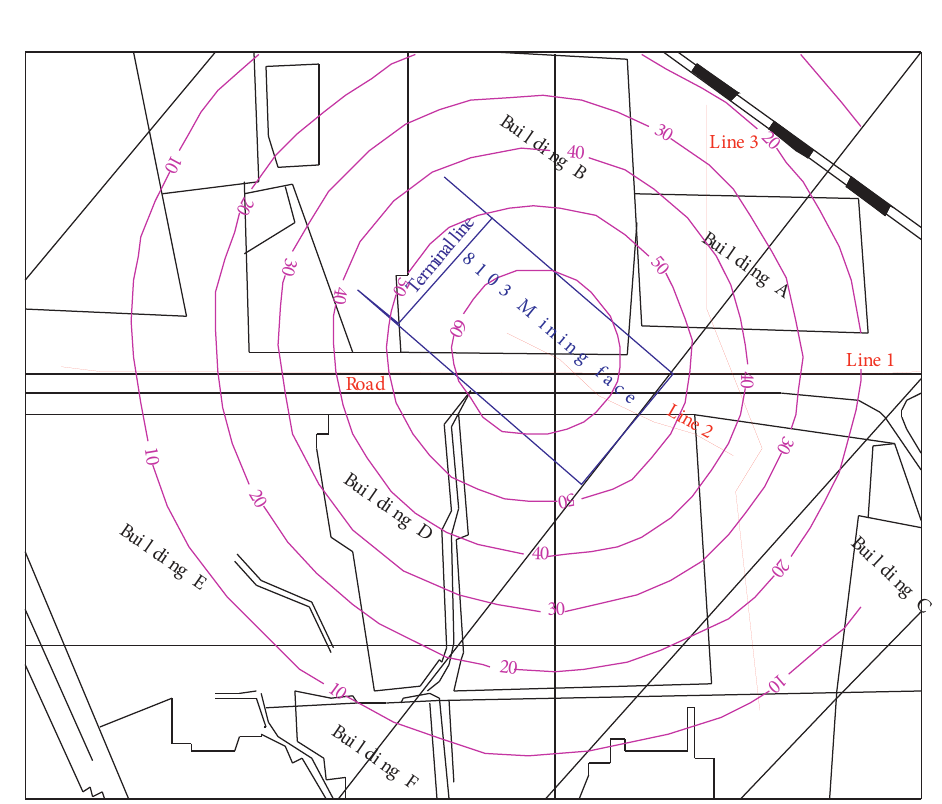
Figure 21: Forecast contour of surface subsidence in 8103 backfilling